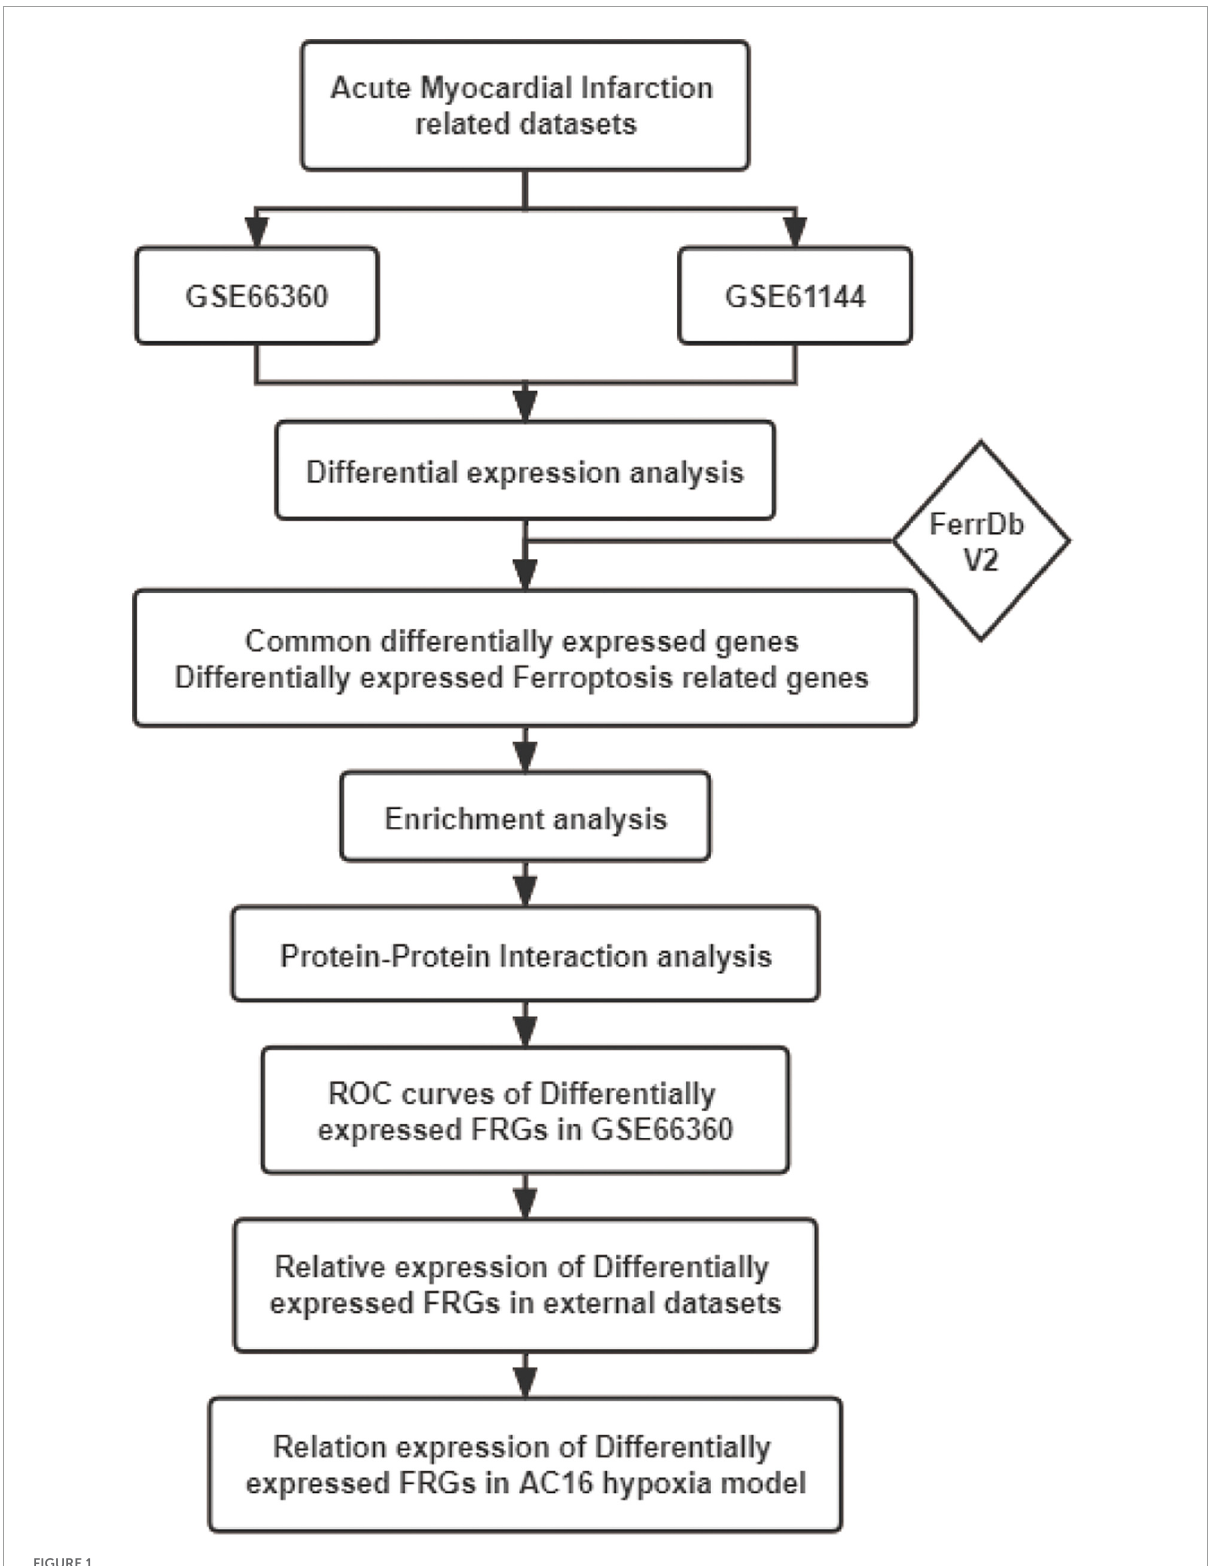
FIGURE1 Flowchart of the steps performed in this